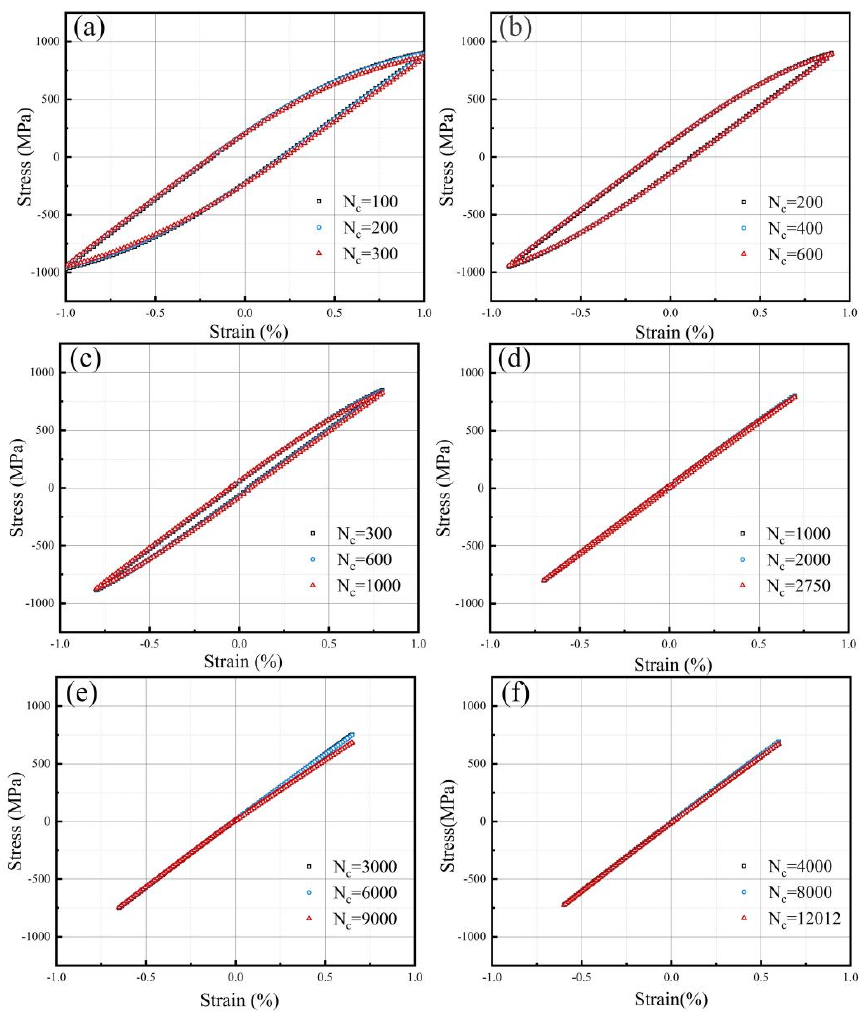
Figure 7. Stress-strain hysteresis curves of the LCF samples after 1/3, 2/3 and near the end of the test cycle at different strain amplitudes: ( a ) 1%; ( b ) 0.9%; ( c ) 0.8%; ( d ) 0.7%; ( e ) 0.65%; ( f ) 0.6%.